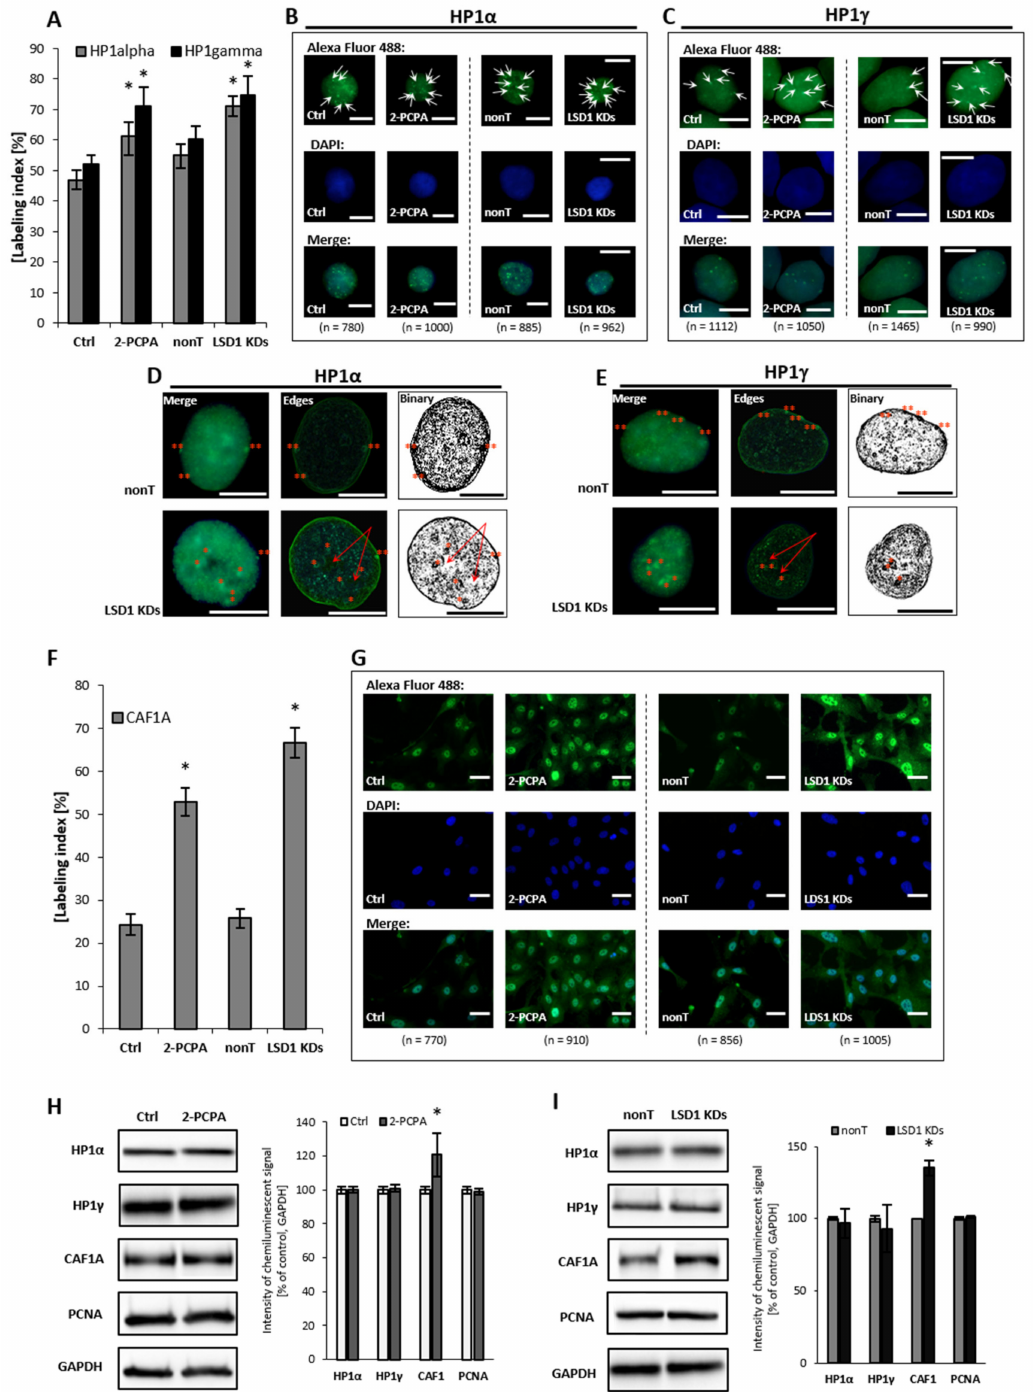
Figure 3. E ff ect of pharmacological and transcriptional inhibition of lysine-specific demethylase 1 (LSD1) on the ‘topography’ of heterochromatin fraction. Immunofluorescent analysis of HP1 alpha and gamma localization ( A – E ) and CAF1A protein ( F , G ). The labeling index was calculated as the ratio of immunofluorescence-labeled cells to all cells in an HMEC-1 cell population. Subfigures D and E show exemplary nuclei from the series “not-treated” (nonT) versus “treated” (LSD1 KDs) for respectively: HP1 alpha protein and HP1 gamma, and enroll the most characteristic location of specific foci, labeling heterochromatin regions at the periphery of the interphase nuclei (double red star), which is usually associated with the nuclear lamina, and perinucleolar heterochromatin (single red star). The red arrows indicate the unlabeled region (the so-called “hole”) in the location of the nucleoli. The protein expression of HP1 aplha, HP1 gamma, and CAF1A by Western blotting in cells treated with 100 µ M of 2-PCPA ( H ), and ( I ) shRNA-transfected HMEC-1. Presented images are representative, and the data are the average of three independent experiments. Scale bars are equal to 10 µ m. * p < 0.05, ANOVA and post hoc analysis by Tukey’s